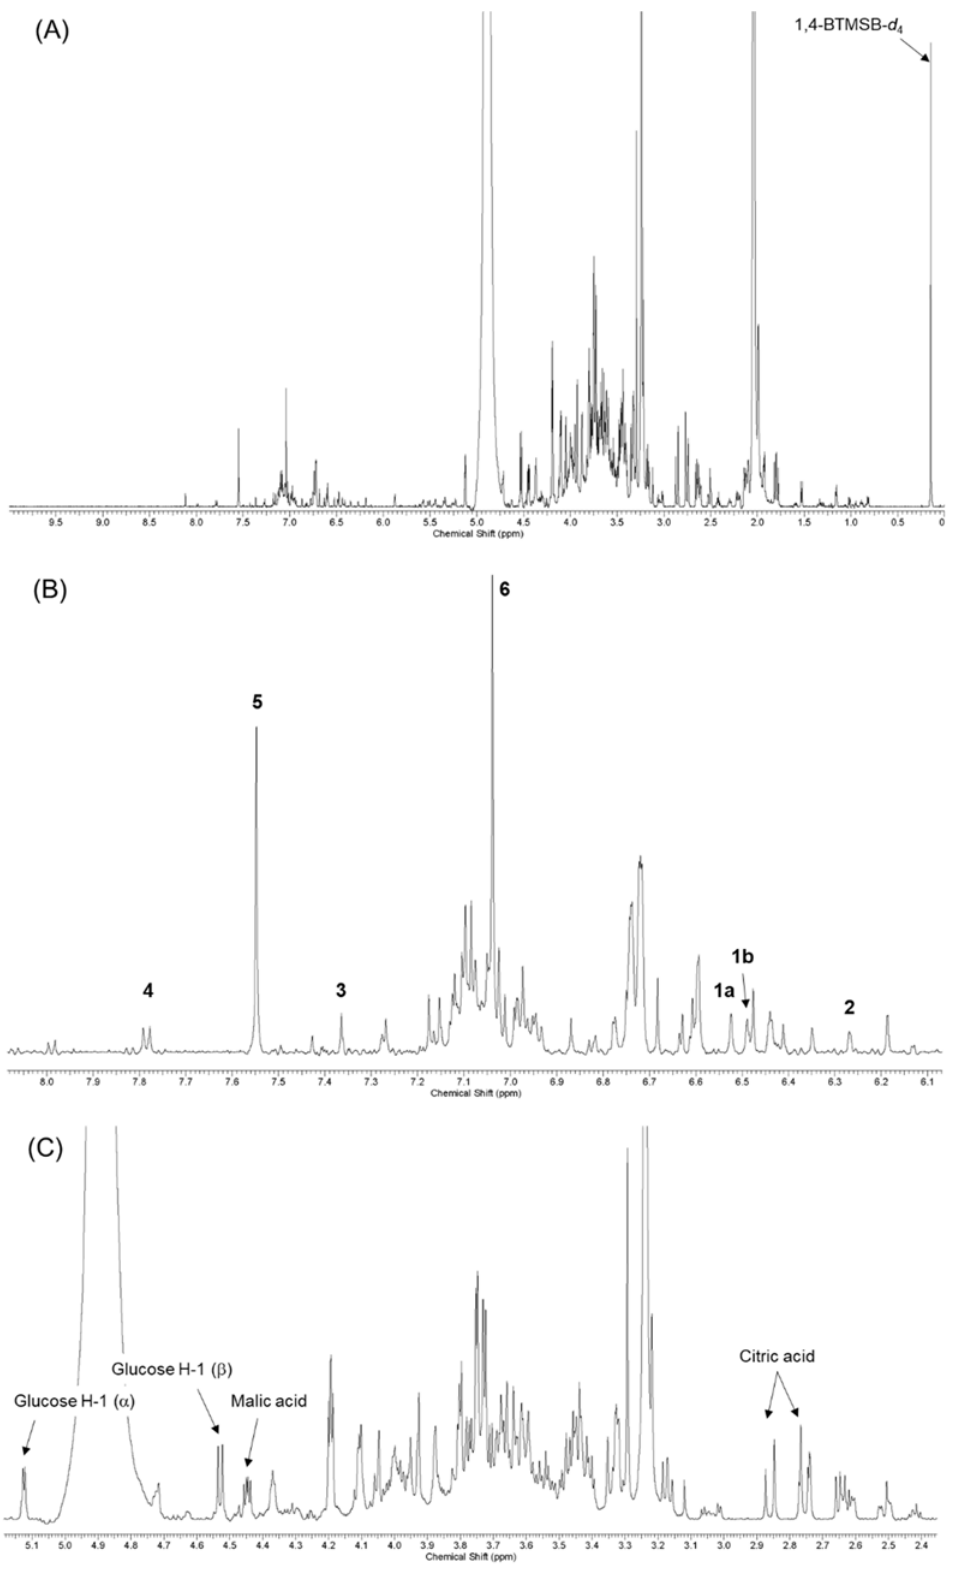
Figure 3. 1 H NMR spectra {600 MHz, acetone ‐ d 6 ‐ CF 3 COOD ‐ D 2 O (70:25:5)} of the short ‐ term decoction Figure 3. 1 H-NMR spectra {600 MHz, acetone- d 6 -CF 3 COOD-D 2 O (70:25:5)} of the short-term decoction of G. thunbergii : ( A ) entire spectrum; ( B ) expansion of the low ‐ field region; and ( C ) expansion of the of G. thunbergii : ( A ) entire spectrum; ( B ) expansion of the low-field region; and ( C ) expansion of the high ‐ field region. high-field